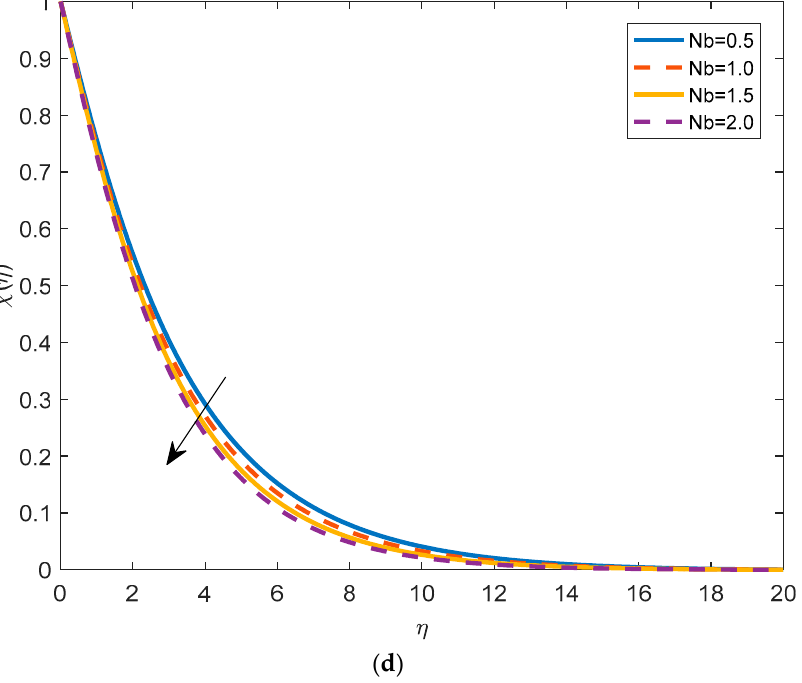
Figure 4. ( a ): Velocity distribution for various Nb when R b = 0.1, Nt = 0.1, M = 0.1, Pr =1.5, W e = 0.2, λ = 0.2, Sc = 0.5, Sc n = 0.5, Pe = 1.0, K p = 0.5 at α = π /6. ( b ): Temperature distribution for various Nb when Rb = 0.1, Nt = 0.1, M = 0.1, Pr = 1.5, W e = 0.2, λ = 0.2, Sc = 0.5, Sc n = 0.5, Pe = 1.0, K p = 0.5 at α = π /6. ( c ): Concentration distribution for various Nb when Rb = 0.1, Nt = 0.1, M = 0.1, Pr = 1.5, W e = 0.2, λ = 0.2, Sc = 0.5, Sc n = 0.5, Pe = 1.0, K p = 0.5 at α = π /6. ( d ): Density of motile micro-organisms for various Nb when Rb = 0.1, Nt = 0.1, M = 0.1, Pr =1.5, W e = 0.2, λ = 0.2, Sc = 0.5, Sc n = 0.5, Pe = 1.0, K P = 0.5 at α = π /6.